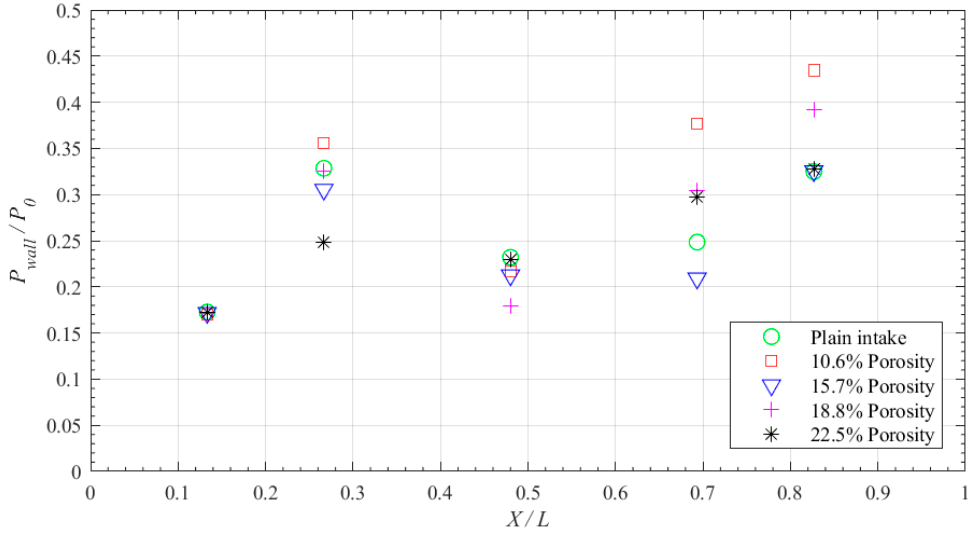
Figure 12. Static pressure variation along the intake-core due to wall ventilation at R c = 1.16.